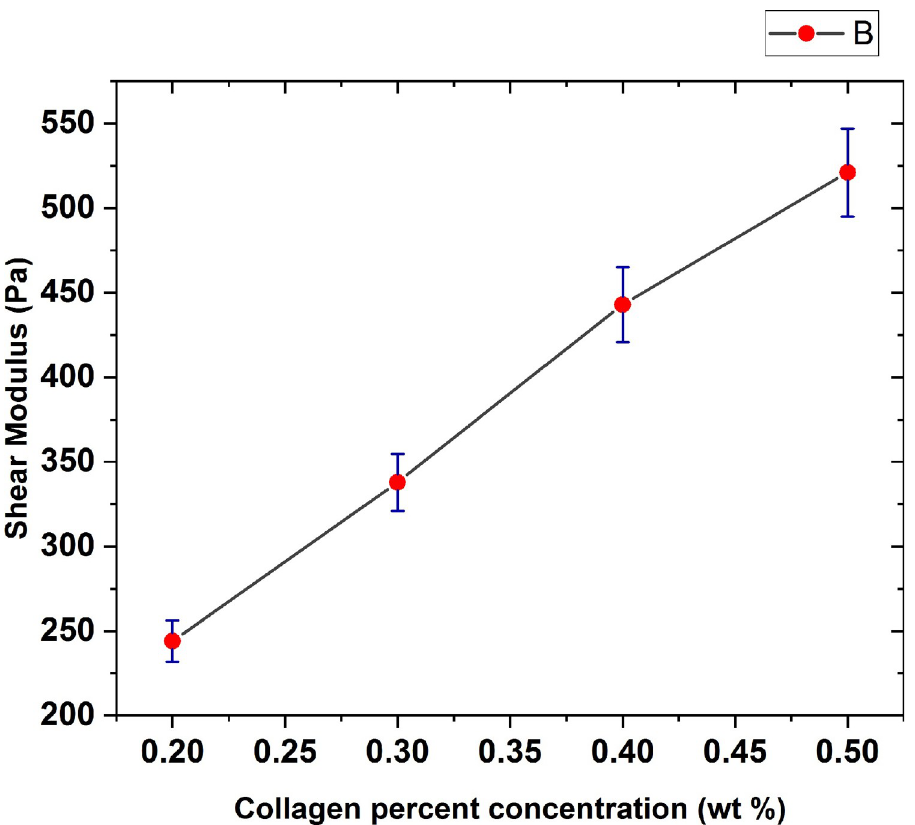
Fig 17. The graph of elastic shear modulus of collagen hydrogels versus gel percent concentration with error bars based on a 95% confidence interval from the fitting procedure.